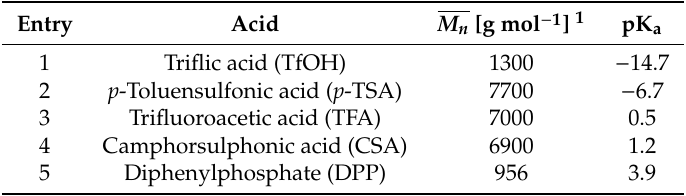
Table 1. Screening of acid catalysts.